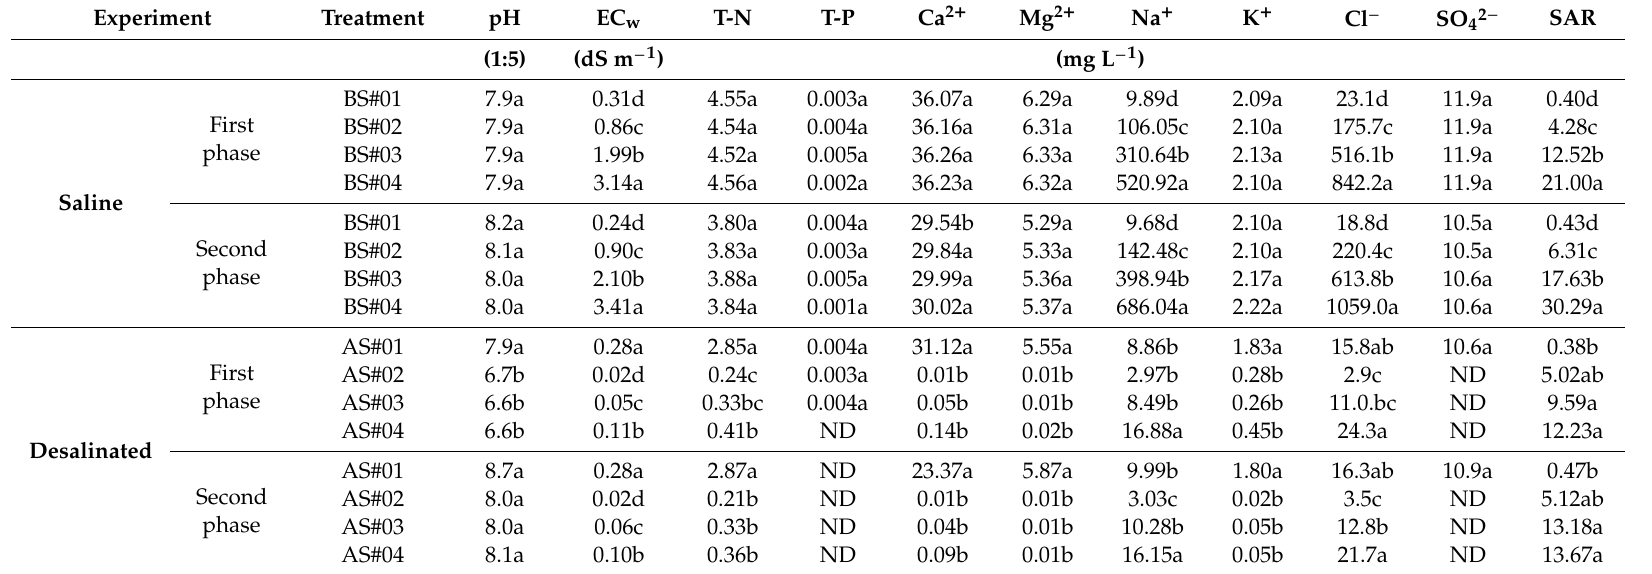
Table 2. Properties of saline and desalinated irrigation water for each treatment and experimental